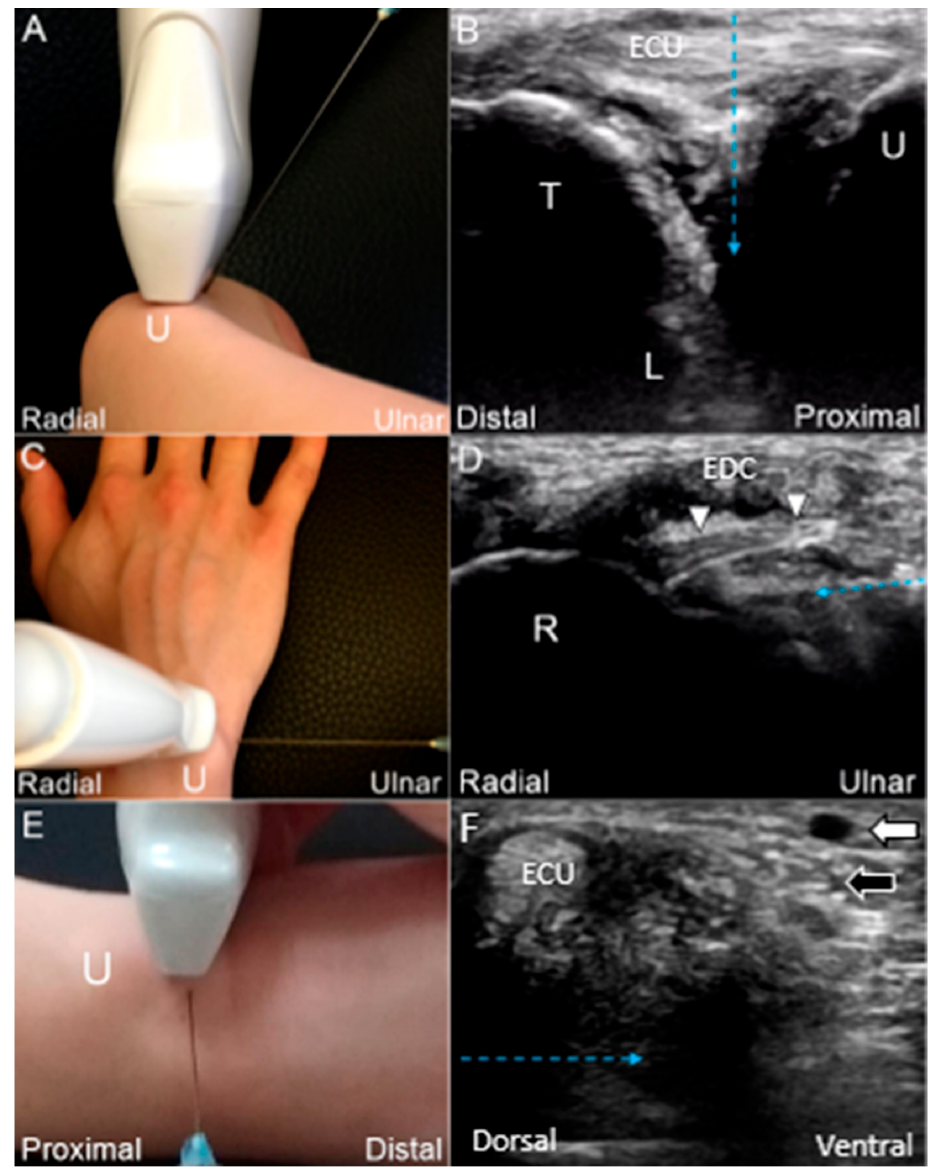
ECU tendon. US: ultrasound; U: ulna; R: radius; L: lunate; T: triquetrum; white arrow: artery; black arrow: dorsal ulnar cutaneous nerve; ECU: extensor carpi ulnaris; EDC: extensor digitorum communis.